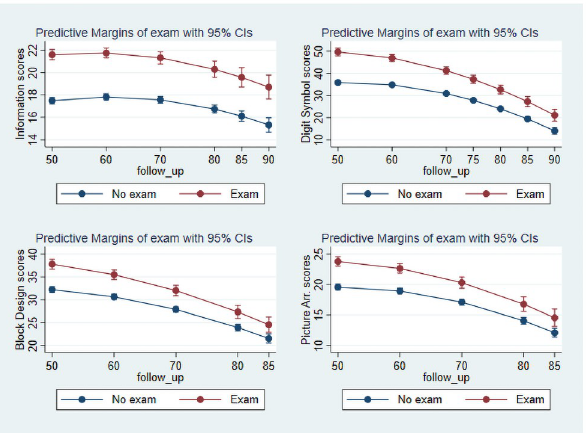
Fig 3. Decline on information, Digit Symbol, Block Design, and Picture Arrangement stratified on education over a 35- to 40-year follow-up. https://doi.org/10.1371/journal.pone.0255449.g003 Table 5 presents mean Full Scale IQ for subsamples defined by the age at the last follow-up with administration of the WAIS irrespective of the reasons for dropping out (e.g. ill-health or being dead). For each age there is an IQ difference of about 6–7 points between the group who will drop out at the next follow-up and the group who participated in the 85-year assessment. Furthermore, for each age the difference between the participants who completed the next fol- low-up and those who did not was increasing (at age 50 this difference was 1.3 IQ points while it was 7.2 at age 80). For the 80-year old participants without the following 85-year follow-up, it is remarkable that the decline from the 50-year baseline is about 17–18 IQ points, corre- sponding to about 1.2 standard deviations on a scale with a theoretical IQ standard deviation of 15. For all subsamples the table shows minimal decline at age 60 compared to age 50. The means in Table 2 suggests little decline in Full Scale IQ between ages 80 and 85, but the means in Table 5 suggest that this is because the 80-year subsample without the 85-year test strongly influenced the 80-year mean since the subsample participating in both assessments declined about 5 IQ points from 89.5 to 84.1. However, it is most likely that at every assessment those who will drop out of the study bring down the mean as a possible consequence of being less healthy and less cognitively intact than those remaining in the study. Fig 4 shows Full Scale IQ trajectories for those who participated in both the 80- and 85-year assessment and those who only participated in the 80-year assessment. A growth curve model Table 5. Full Scale IQ means for subsample completing the 50-, 60-, 70-, 80- and 85-year follow-ups, respectively. Age at last follow-up